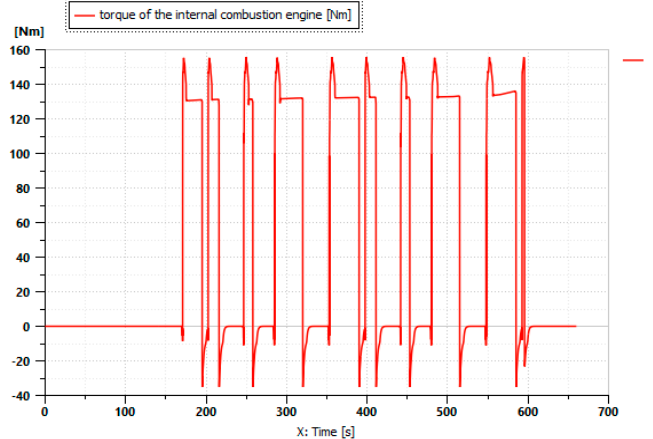
Figure 12. Thermal engine torque.